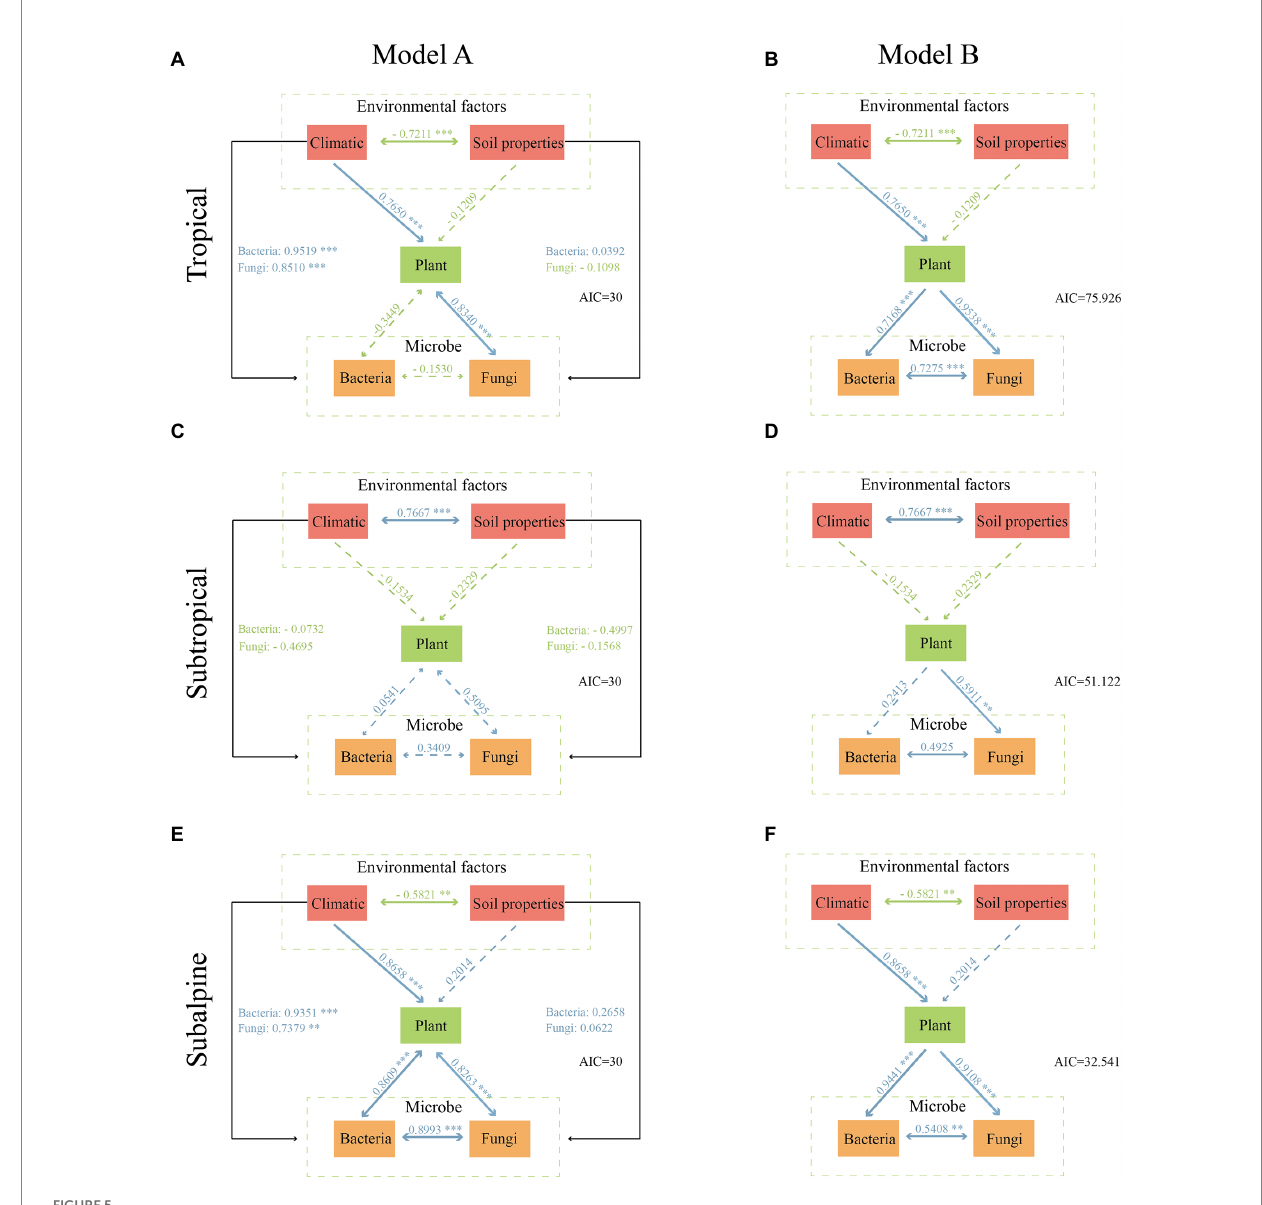
FIGURE 5 Piecewise structural equation model. We performed principal component analysis of environmental factors (climatic and soil properties), plant diversity, and microbial diversity to extract data on the first axis (PC1, explained variance >70%). Model A: environmental factors directly affect microorganisms and plants. Model B: environmental factors directly influence plant diversity, which in turn affects microorganisms. (A,B) tropical; (C,D) subtropical; (E,F) subalpine. Arrows represent unidirectional or bidirectional relationships among variables. Blue and green arrows denote positive and negative relationships, respectively. Dashed arrows indicate nonsignificant relationships ( p ≥ 0.05). The thickness of the arrow paths indicates the magnitude of the standardized regression